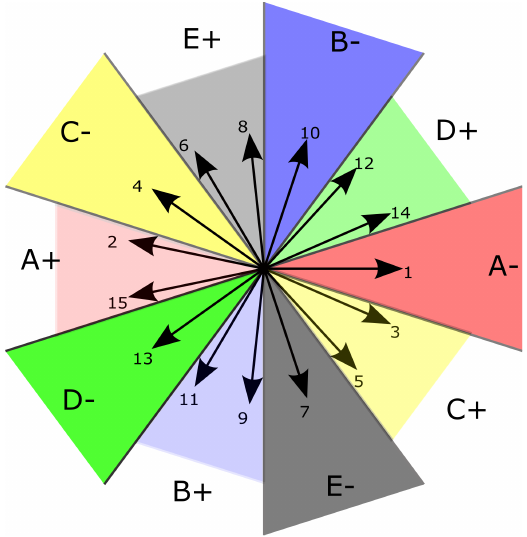
Figure 10. Star of slots of the five phase FSPMSM under study.